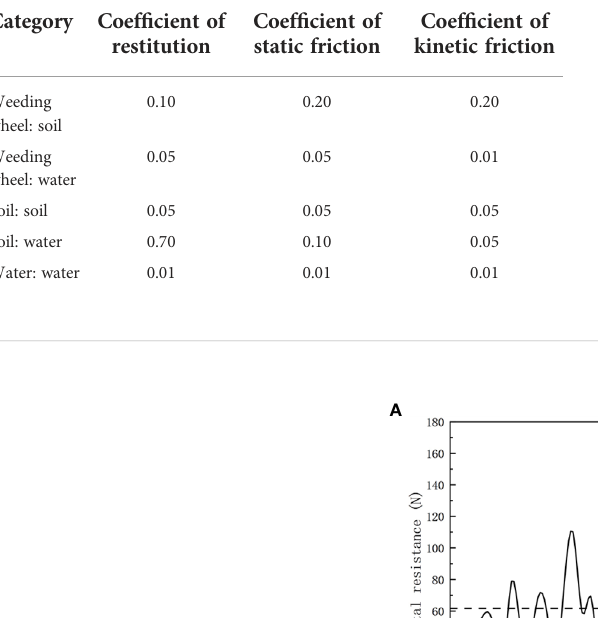
TABLE 1 Contact parameter table of simulation